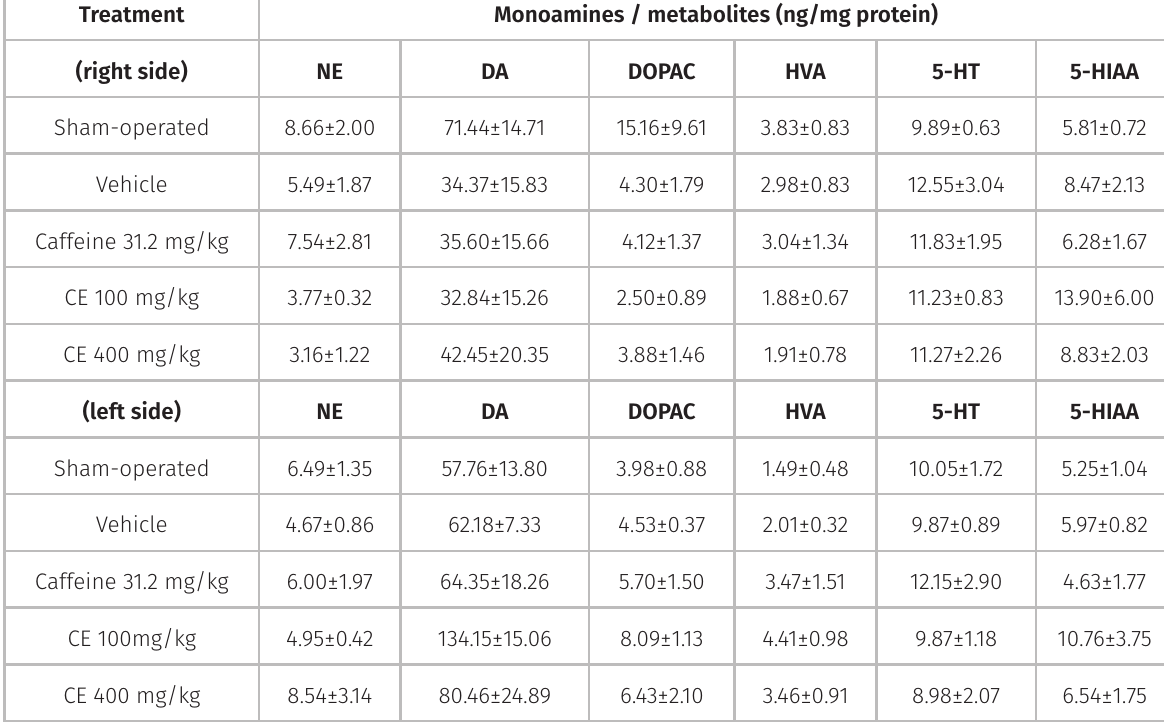
Table I. Treatments with CE or caffeine do not change the levels of monoamines compared to control group. Monoamines dosage (HPLC) in the right and left striatum of animals with lesion in the right side of medial forebrain bundle (MFB) and in sham-operated animals. Data are expressed as mean ± standard error of mean